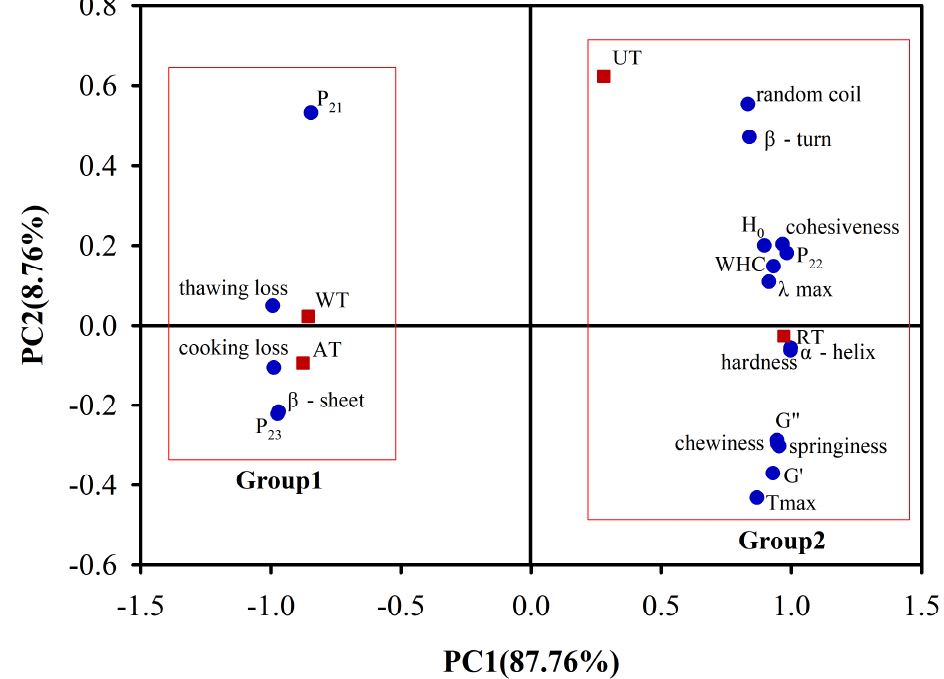
Figure 6. Principal component analysis (PCA) of water retention, mechanical properties, and protein properties of instant sea cucumbers thawed with different thawing